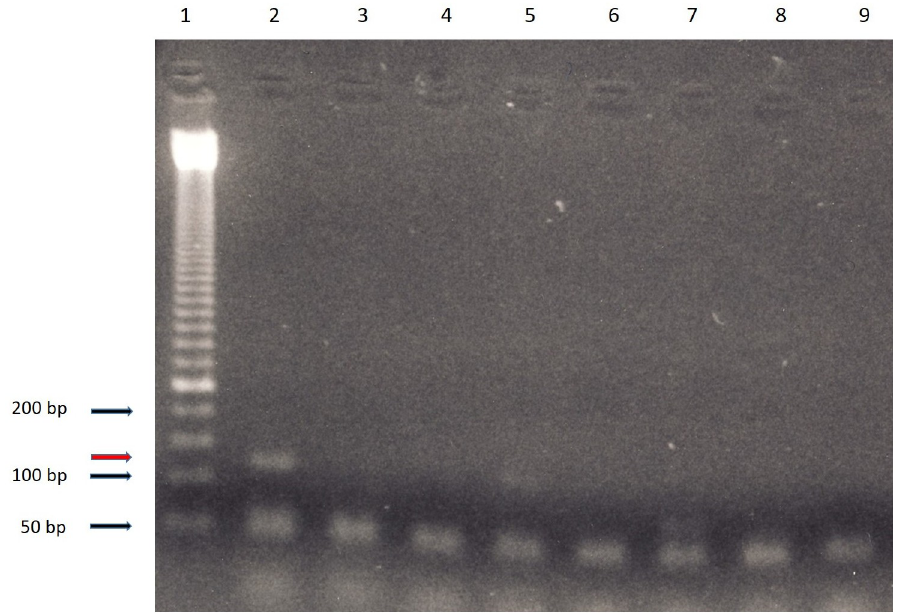
Fig 18. Gel electropherogram of the amplification products of the mummy´s tissues. 1 size ladder; 2 sample of the cyst wall; 3–6 various samples from both peripheral lungs; 7 sample from the right pulmonary hilus (calcified nodule); 8 sample from the L2 vertebral body; 9 negative control. The amplicon sizes are indicated in the left (dark arrows); the target amplicon size of 123 bp is shown by the red arrow (left).